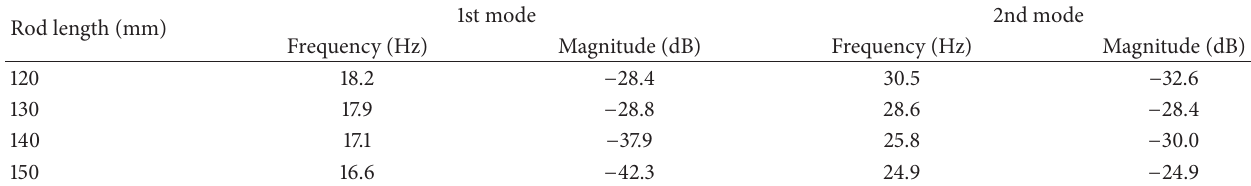
Table 3: Frequencies and magnitudes of beam with TMD.